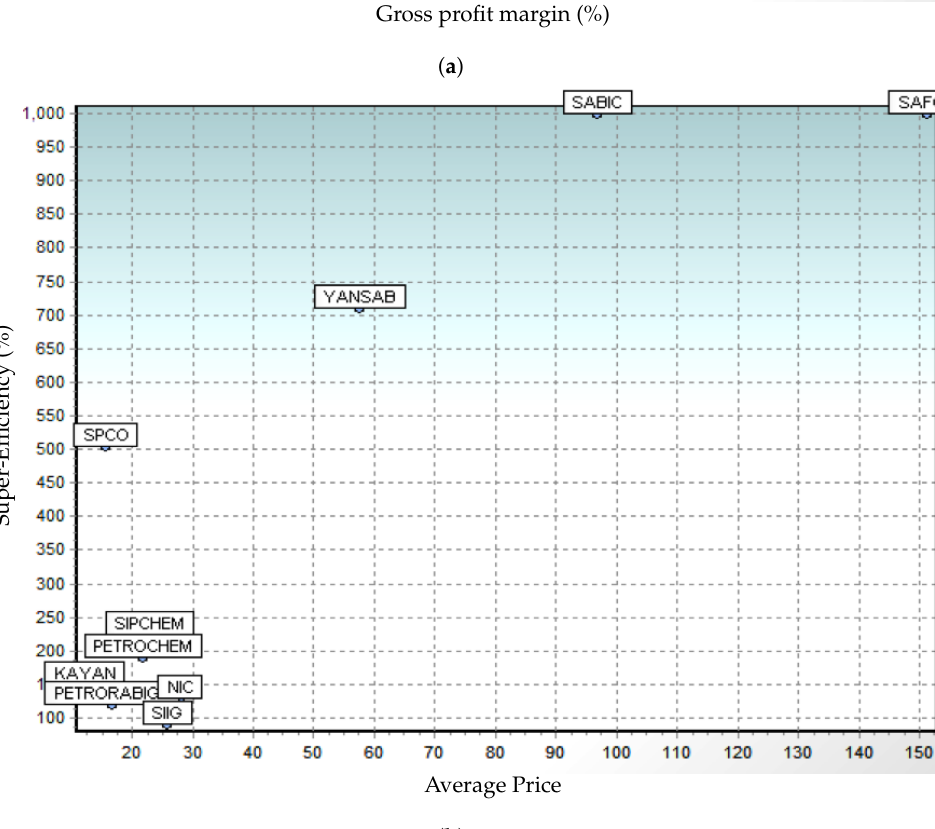
Figure 1. Efficiency plots of the decision-making units